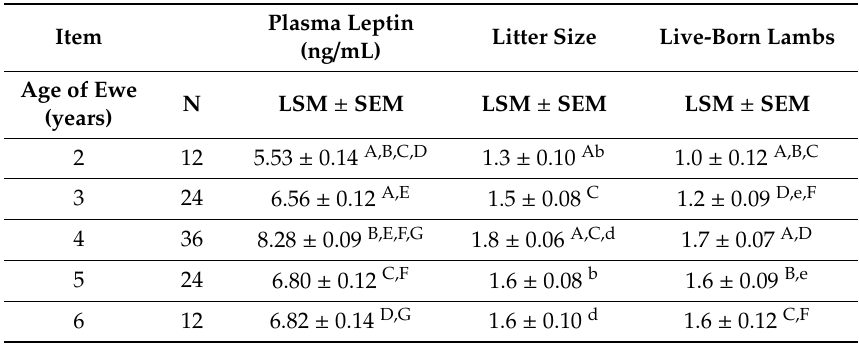
Table 2. The distribution of number of ewes in age groups, average plasma leptin concentration, litter size and live-born lambs of the ewes by age.